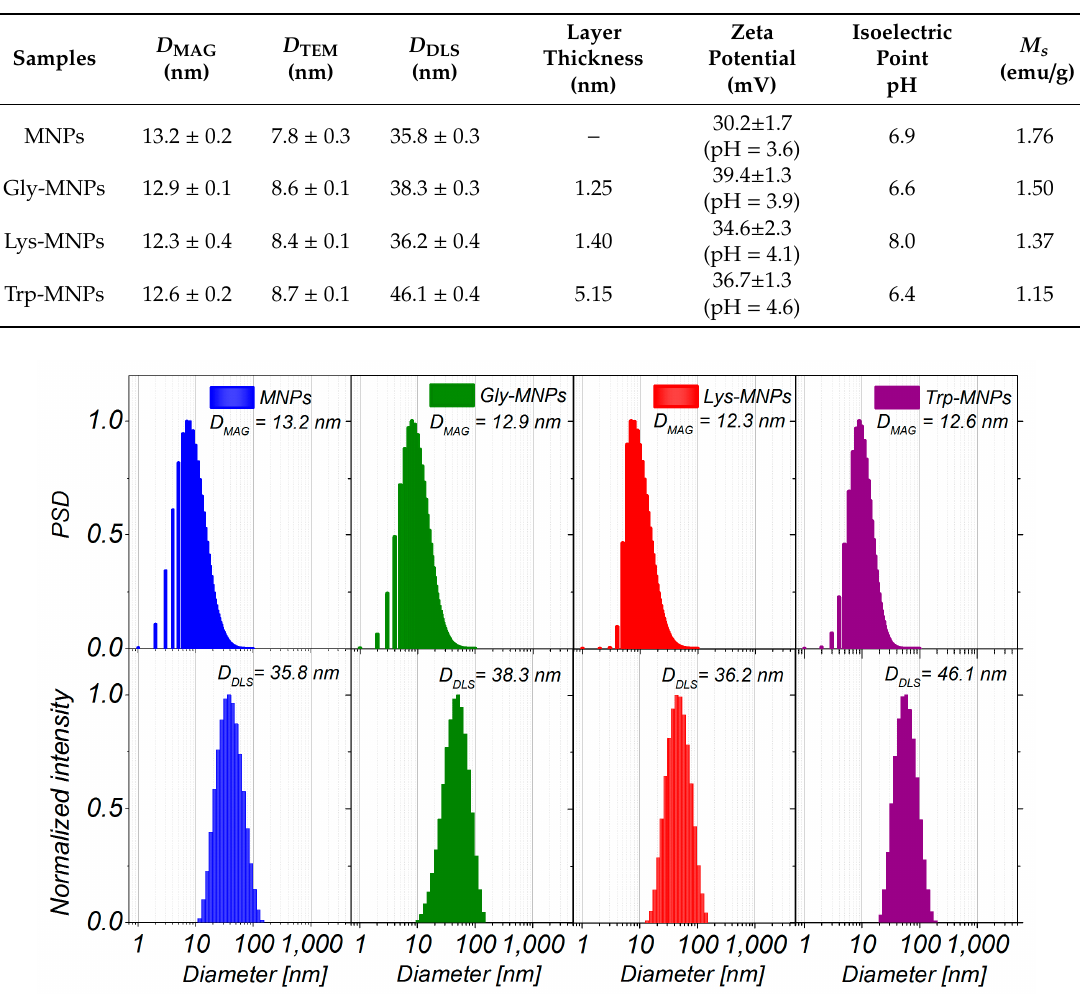
Figure 4. The particle size distribution of magnetic cores obtained from magnetic measurements (upper row), and the size distribution of MNPs, Gly-MNPs, Lys-MNPs, and Trp-MNPs obtained by dynamic light scattering (DLS) technique (lower row).